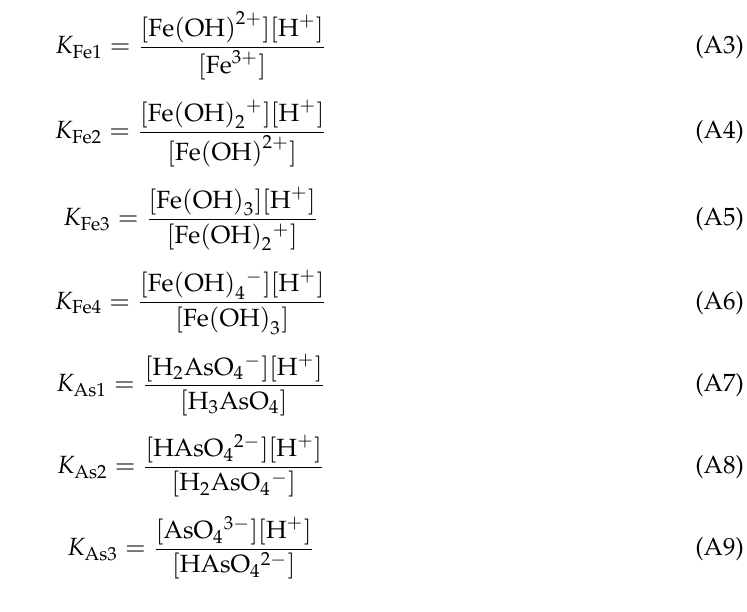
Table A2. Review of TCLP test results (revised from Gonzalez-Contreras et al., 2012 [12]).